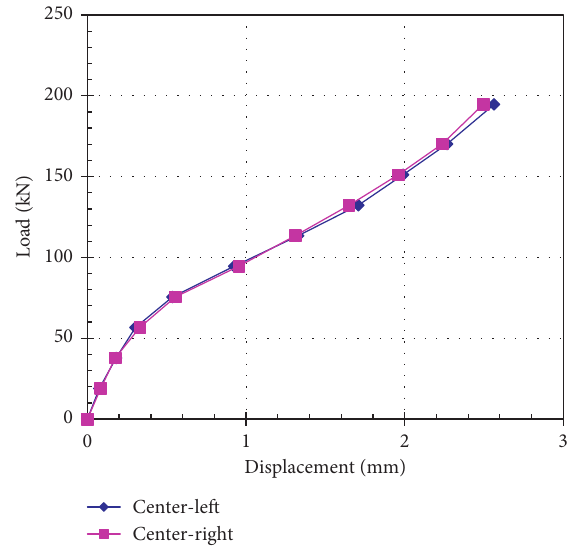
Figure 22: Load-displacement curve of PLG-2 midspan (before dynamic load).